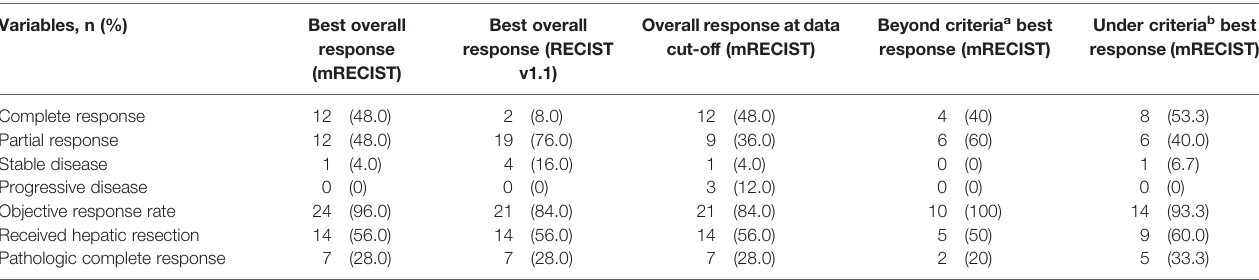
TABLE 3 | Summary of ef fi cacy outcomes (n = 25). Variables, n